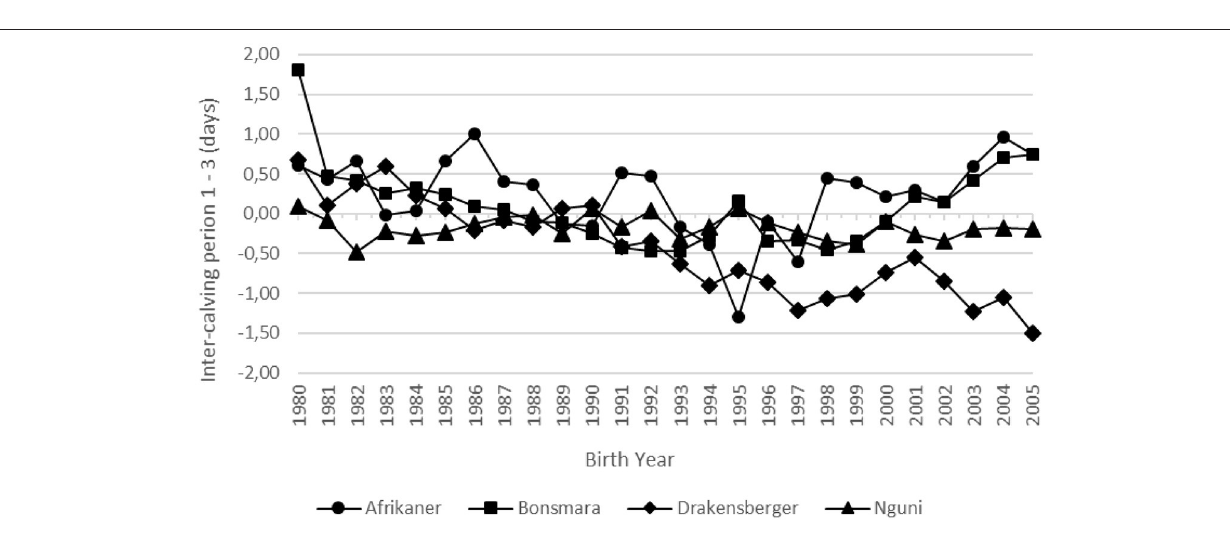
FIGURE 7 | Genetic trend for inter-calving period in